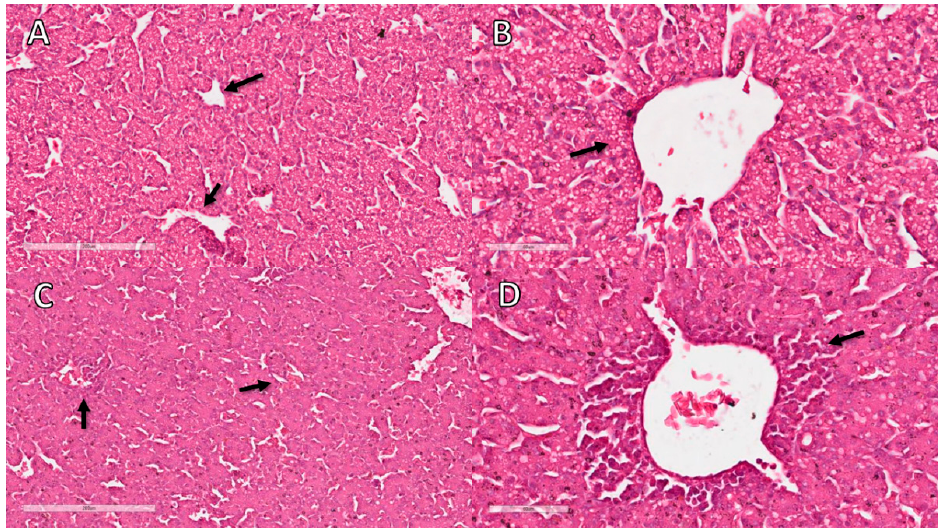
Figure 2. Histopathological analysis of CE liver infected with Gammacoronavirus at 10 EID. ( A ) NC sample showing sinusoids with a minimal number of erythrocytes (arrow). ( B ) NC sample without perivascular inflammatory infiltrates (arrow). ( C ) Liver of virus-infected CE with congestion characterised by erythrocyte-filled sinusoids (arrows). ( D ) Liver of virus-infected CE with inflammatory infiltrate (arrow). The bars in images ( A , C ) represent 200 µm and the bars in images ( B , D ) represent 60 µm. Table 4. Evaluation of CE’s viability, lesions and embryonic mortality when treated with FG and DX at different